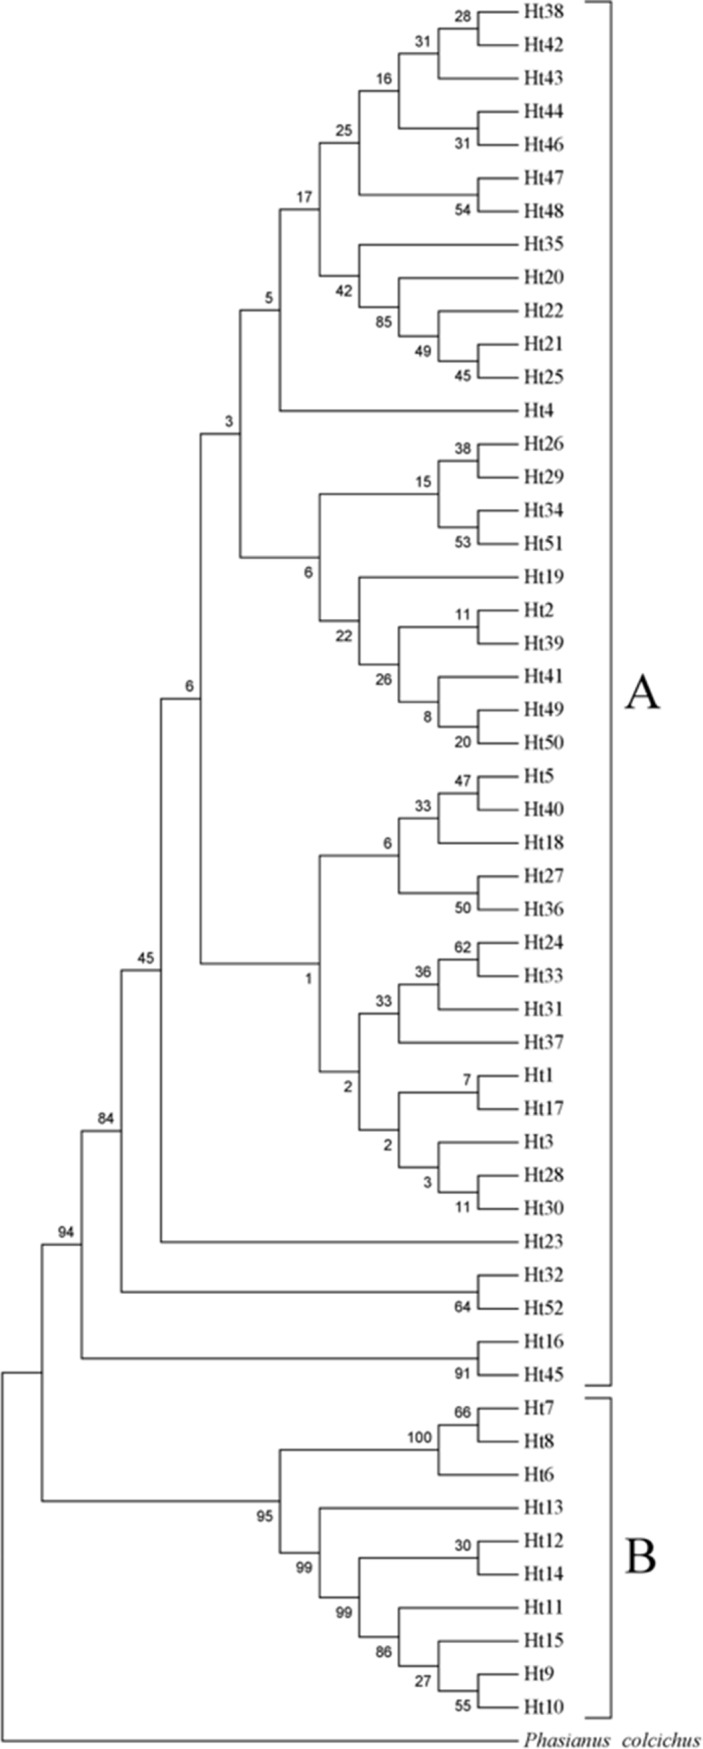
Maximum likelihood bootstrap tree phylogeny based on the joint (present and Genbank sequences) data set from the mtDNA COI region of Streptopelia decaocto.Numbers above the branches refer to NJ bootstrap values. Brackets highlight the two genetic groups. Phasianus colchicus (JN850750.1) was used as outgroup.